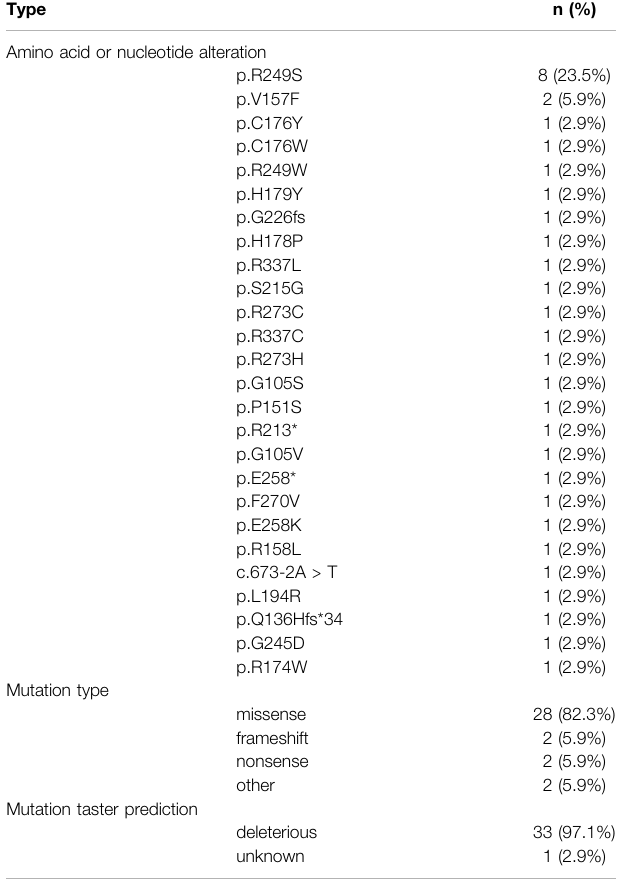
TABLE 3 | The variant types and mutation taster prediction of TP53. Type n (%) Amino acid or nucleotide alteration